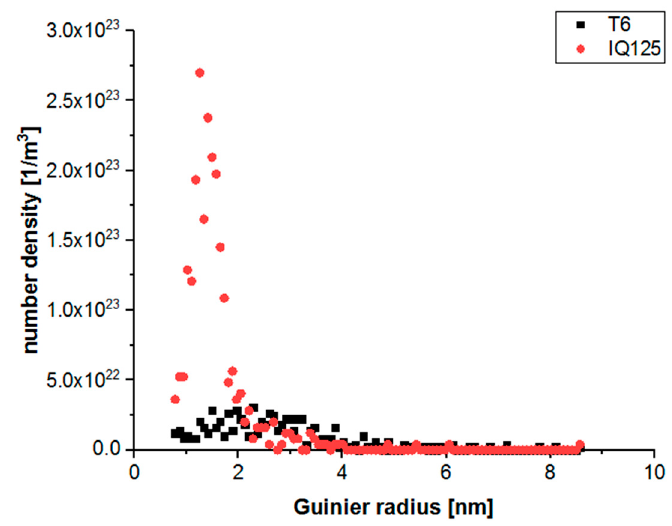
Figure 7. Size distribution of the precipitates in T6 and IQ125, expressed as Guinier radius. T6 state in black and IQ125 in red.